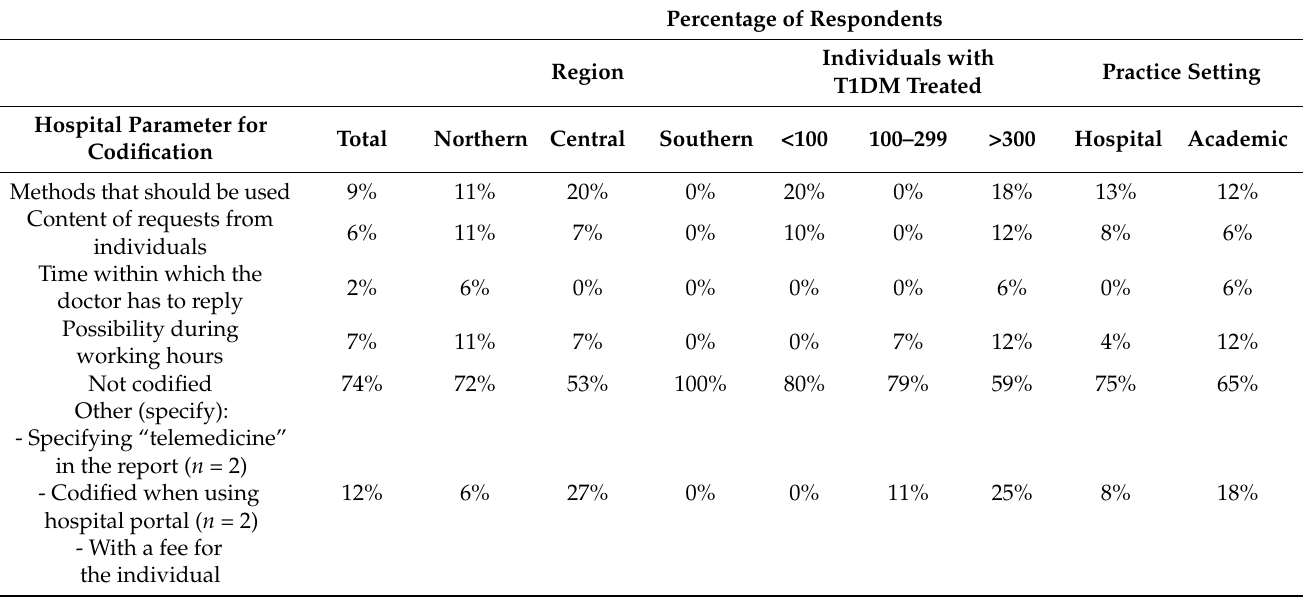
Table 3. Codification of telemedicine activities.